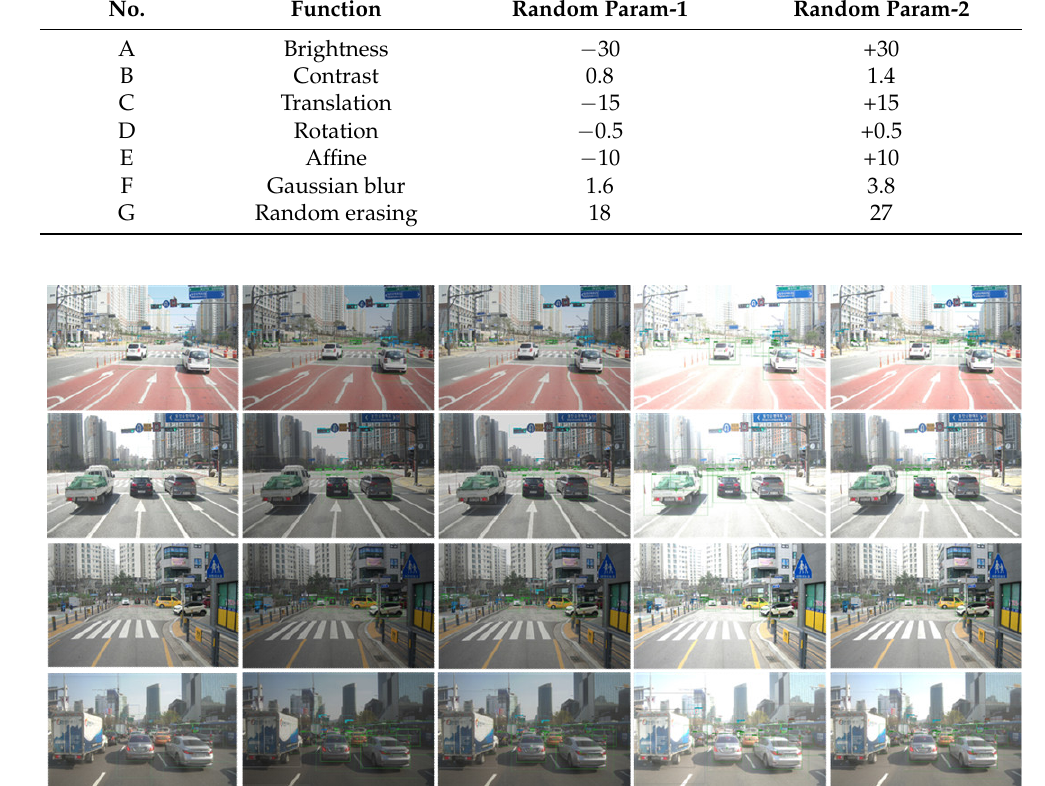
Figure 13. Augmentation test (first column, original image): ( a ) contrast (daytime), ( b ) contrast (night), ( c ) translation, ( d ) affine, and ( e ) random erase.